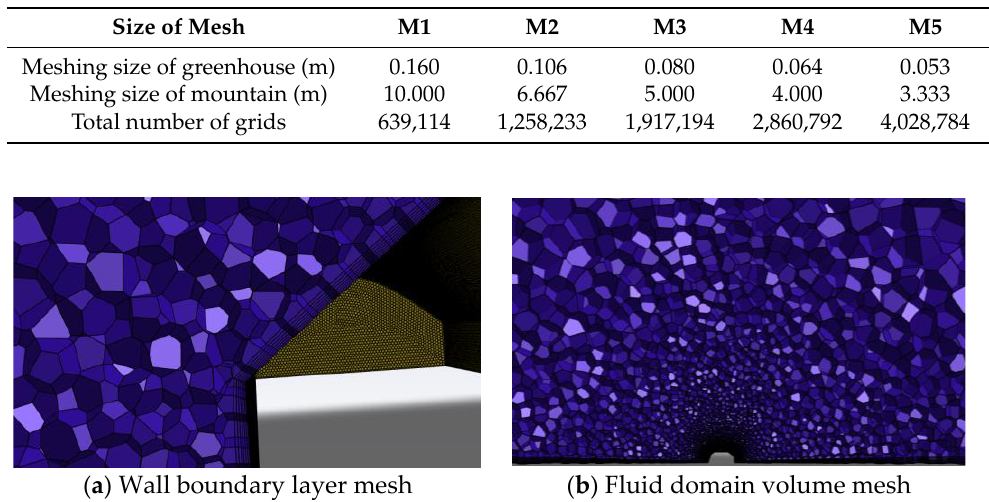
Figure 5. Schematic diagram of polyhedron mesh generation and boundary layer mesh.